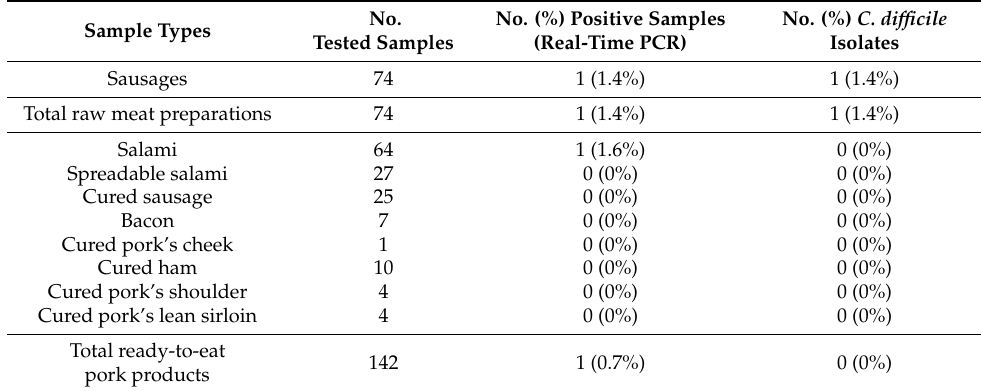
Table 1. Prevalence of C. difficile in pork products (raw meat preparations and ready-to-eat products).